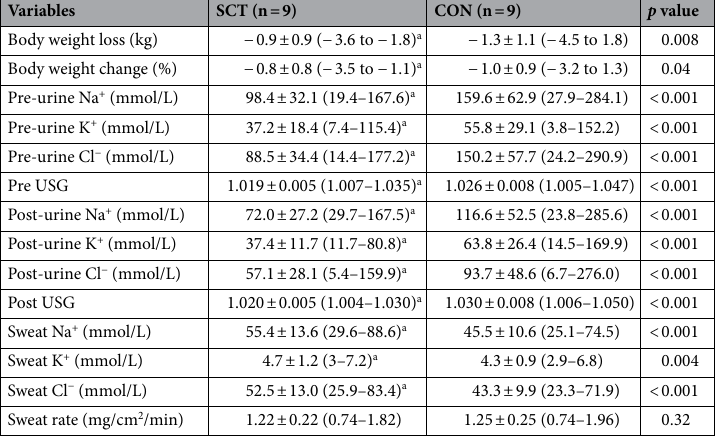
Table 4. Football pre-season camp practice hydration markers by groups. Pre pre-practice, Post post-practice, SCT sickle cell players, CON position-matched control. a Significant difference in SCT compared to CON, data were presented as mean ± SD (range) of averaged practices in the pre-season training